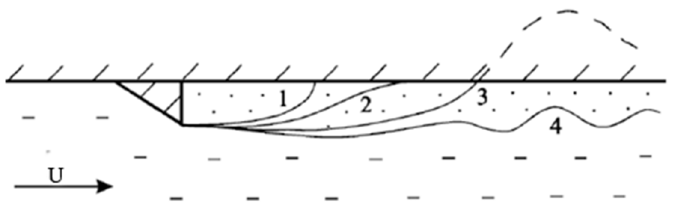
Figure 12. Four two-dimensional cavity flow patterns. (Reproduced with permission from Matveev K I, Ocean Engineering ; published by Elsevier,